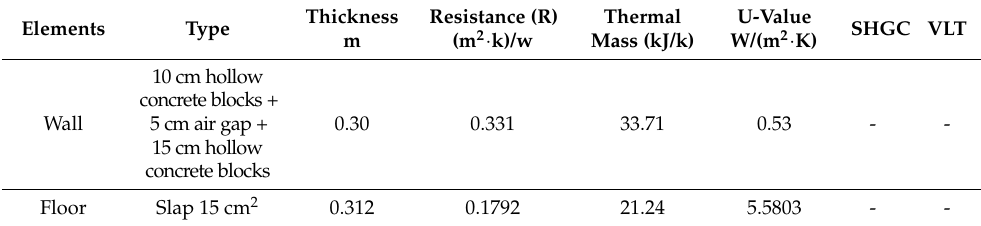
Table 7. Envelope components’ analytical properties (Case